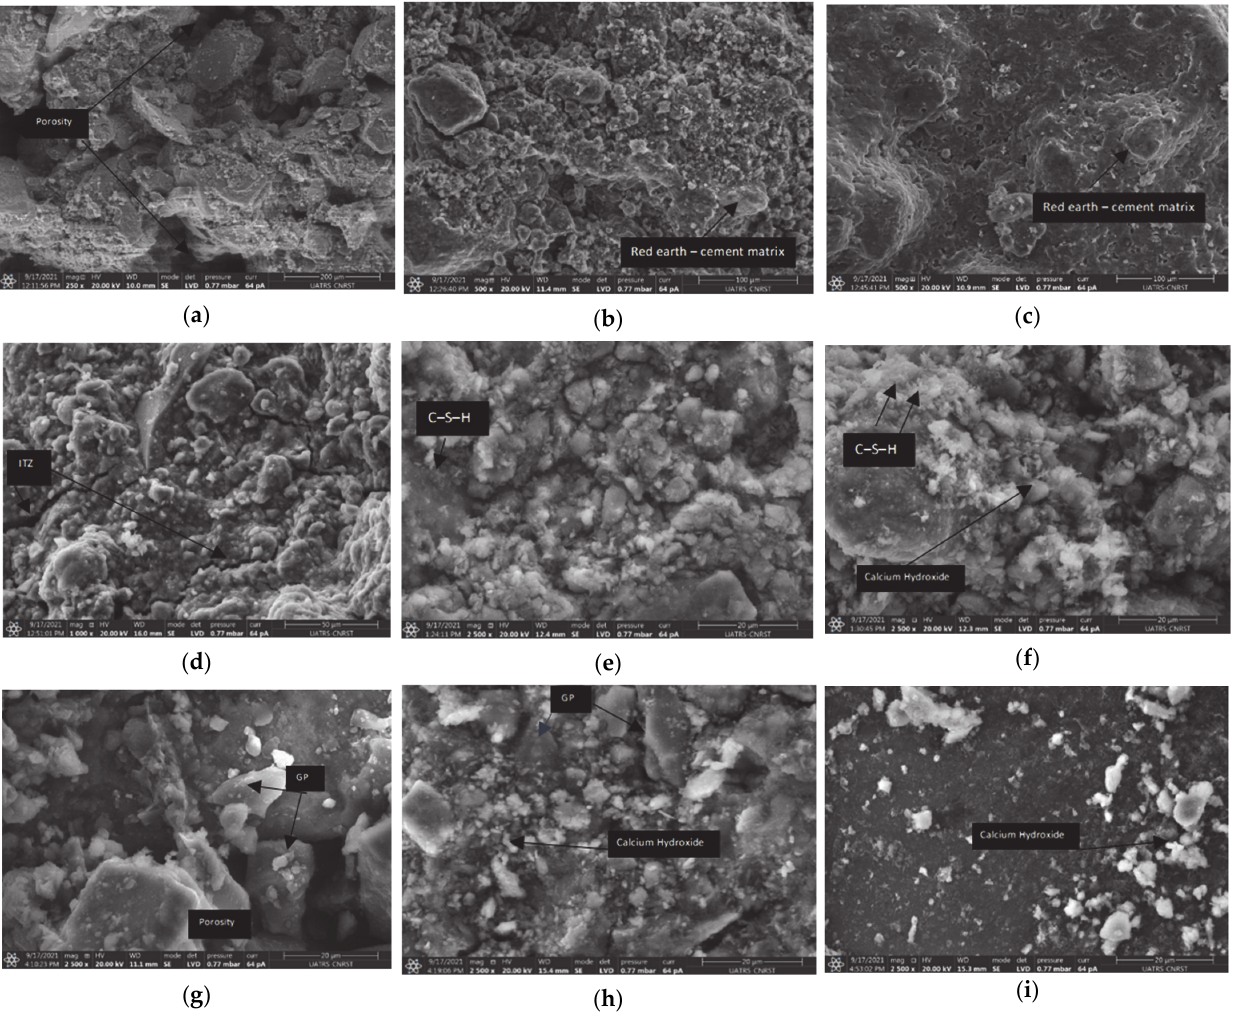
Figure 6. Scanning electron microscopy of ternary composite material sampling: ( a ) control sample (RSB); ( b ) 0% GP + 6% cement; ( c ) 0% GP + 12% cement; ( d ) 10% GP + 0% cement; ( e ) 10% GP + 6% cement; ( f ) 10% GP + 12% cement; ( g ) 30% GP + 0% cement; ( h ) 30% GP + 6% cement; ( i ) 30% GP + 12% Table 3. Chemical composition of ( a ) control sample (RSB), ( b ) 0% GP + 6% cement, ( c ) 0% GP + 12%